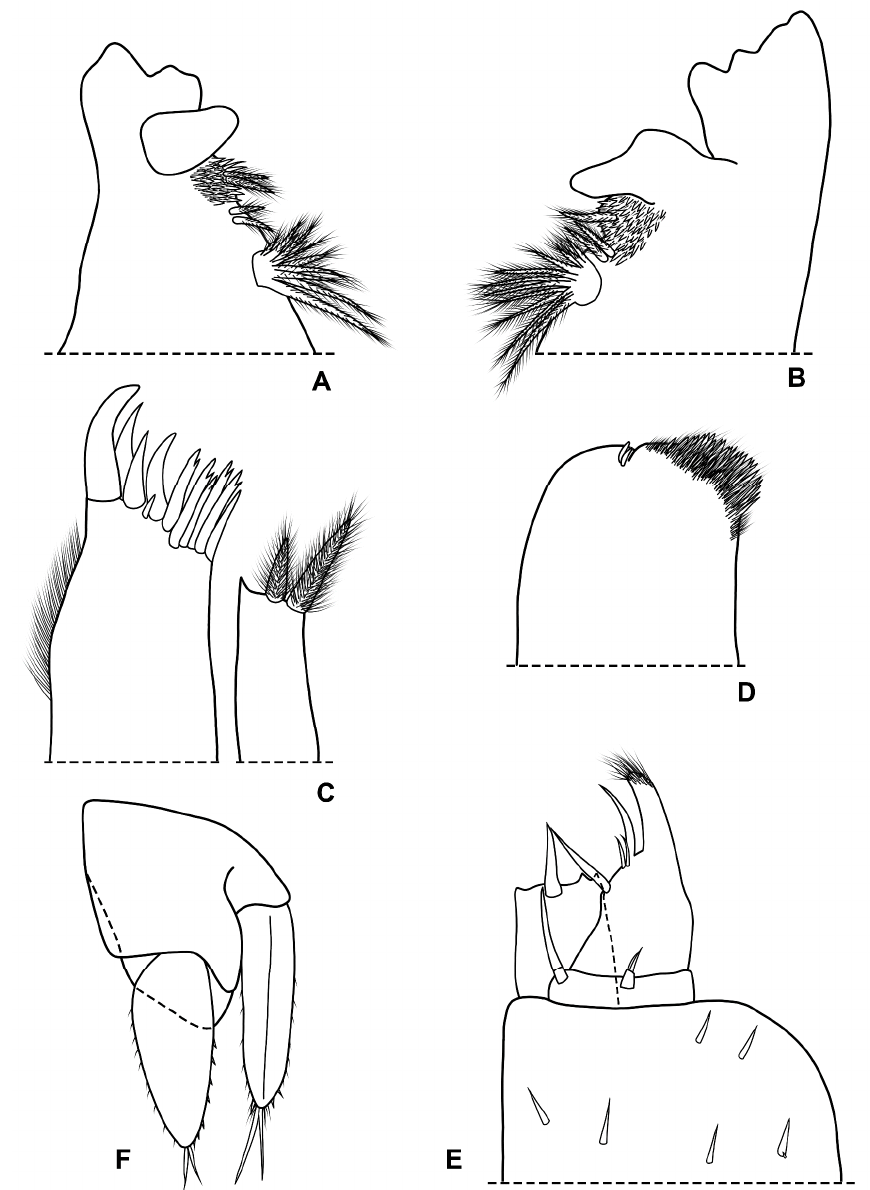
Figure 8. Cylisticus poggii sp. n., paratype ♀ from Isola del Tino. ( A ) Left mandible. ( B ) Right mandible. ( C ) Maxillula. ( D ) Maxilla. ( E ) Maxilliped. ( F ) Left uropod.